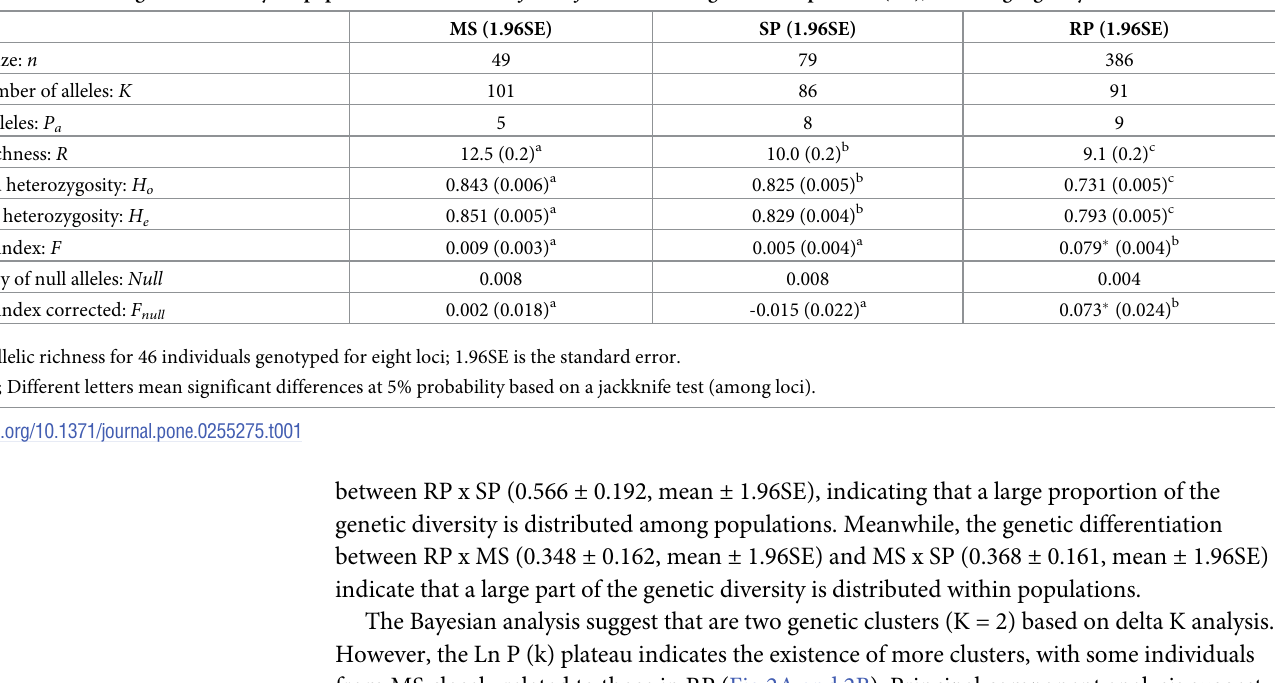
Table 1. Results of mean genetic diversity for populations of Astronium fraxinifolium in the Regenerant Population (RP), and along highways of MS and